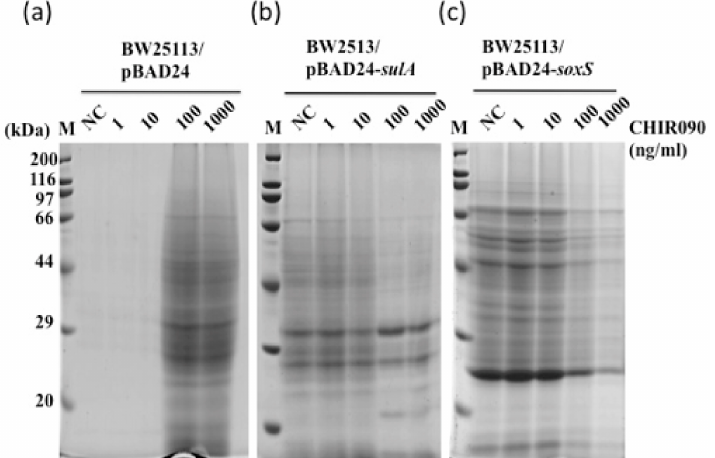
Figure 5. Effects of CHIR-090P, an LpxC inhibitor, on SDCL. BW25113 cells harboring pBAD24 ( a ), pBAD24- sulA ( b ) (SulA: 18.8 kDa) and pBAD24- soxS ( c ); (SoxS: 12.9 kDa) were grown in LB medium containing ampicillin. L-Arabinose (at a final concentration of 0.01%) and CHIR-090 (at a final concentration of 0, 1, 10, 100 or 1000 ng/mL) were added at OD 600 of about 0.5, and portions of the culture were taken at 24 h after induction. Sample preparation for SDS-PAGE was performed as described in the Materials and Methods